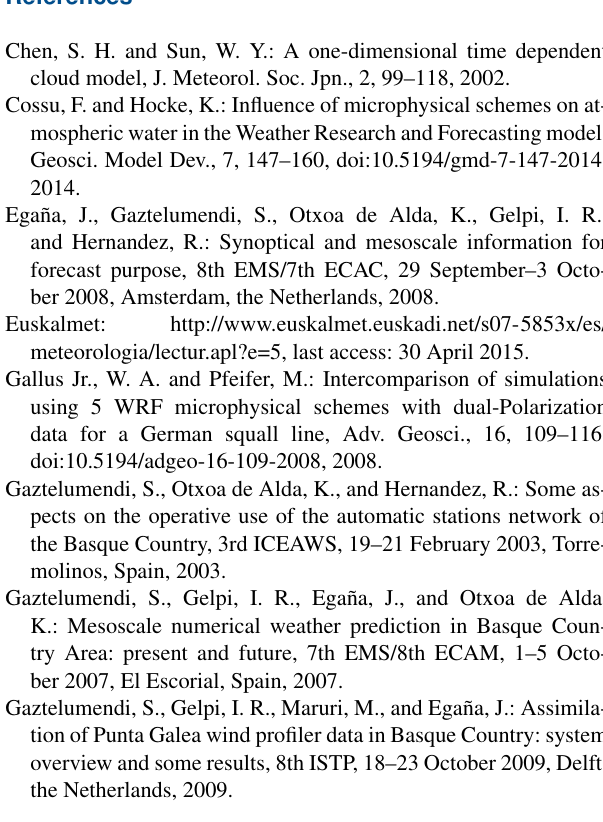
Table 4. Error index values for accumulated precipitation forecast for the full set of experiments, considering all the AWS located at river